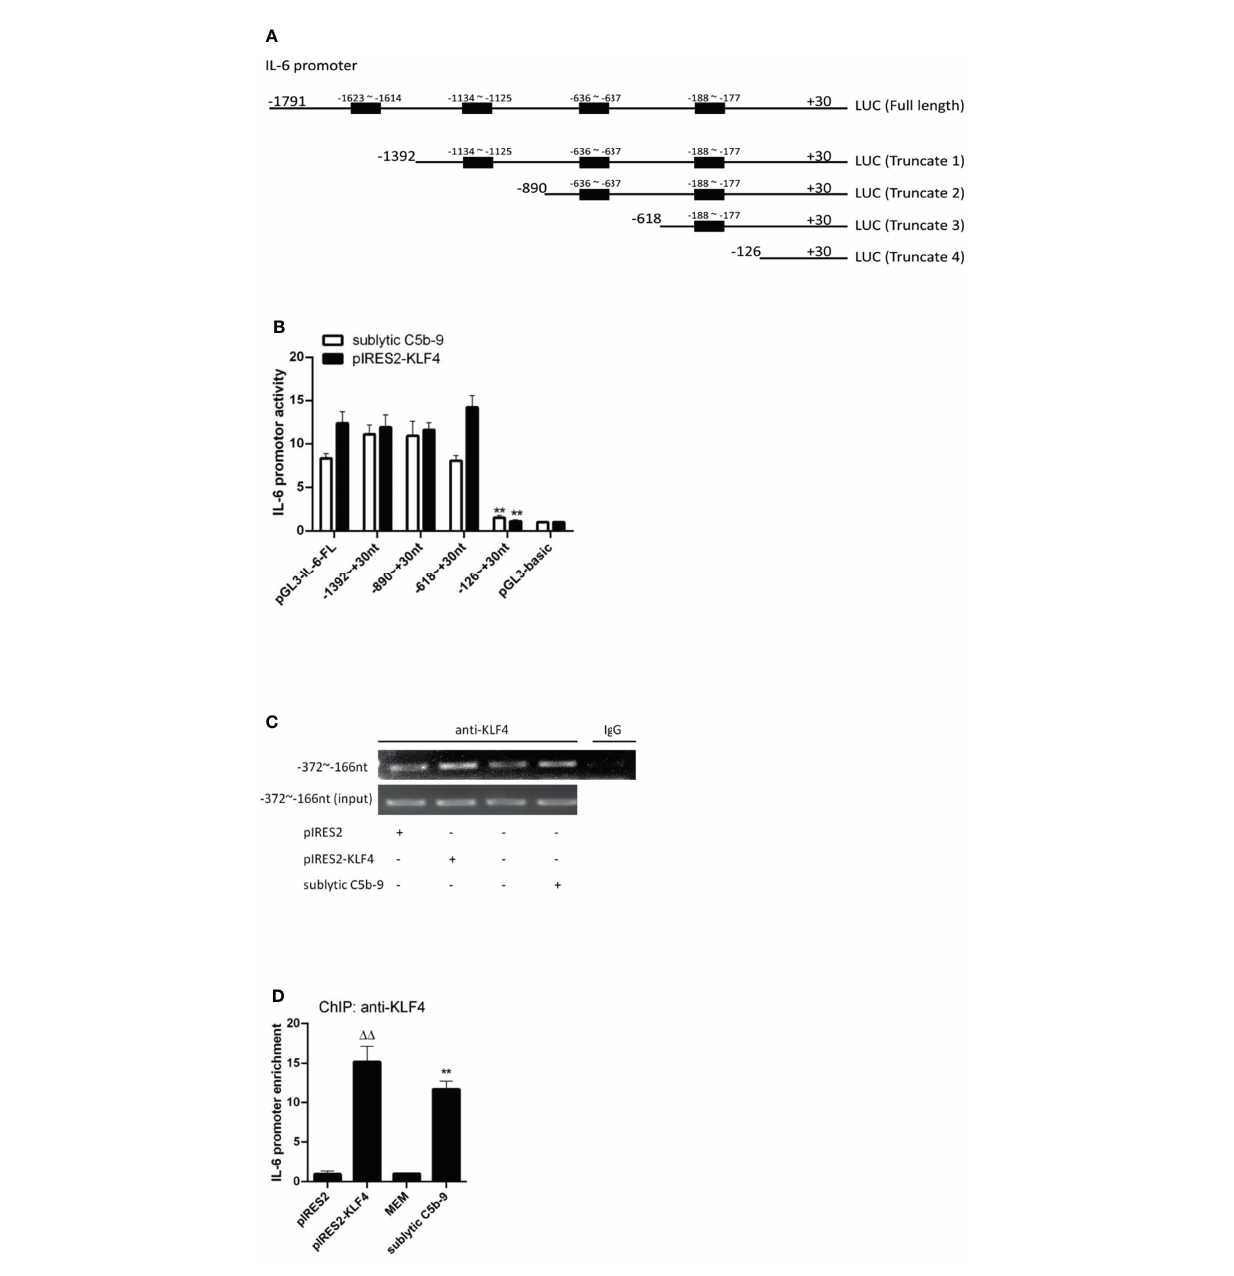
FIGURE 3 | Identi fi cation of KLF4 binding site on rat IL-6 gene promoter. (A) Schematic representation of IL-6 promoter deletion mutants used. (B) Luciferase activity assay of IL-6 reporter in GMCs transfected with full length (FL) or different truncation mutants of IL-6 reporter accompanied by sublytic C5b-9 stimulation for 3 h or together with pIRES2-KLF4 transfection for 48 h (**p < 0.01 vs. pGL3-IL-6-FL). (C, D) ChIP – RT-PCR (C) and ChIP – qPCR (D) analyses of KLF4 enrichment on IL-6 promoter ( − 372 to − 166 nt) in GMCs transfected with pIRES2, or pIRES2-KLF4 for 48 h and then incubated with sublytic C5b-9 or without sublytic C5b-9 (i.e., MEM control) for 3 h (**p < 0.01 vs. MEM; DD p < 0.01 vs. pIRES2). Data are representative of three independent experiments with similar results or are shown as mean ± SD from three independent experiments. GMCs, glomerular mesangial cells; ChIP, chromatin immunoprecipitation; MEM, minimum essential